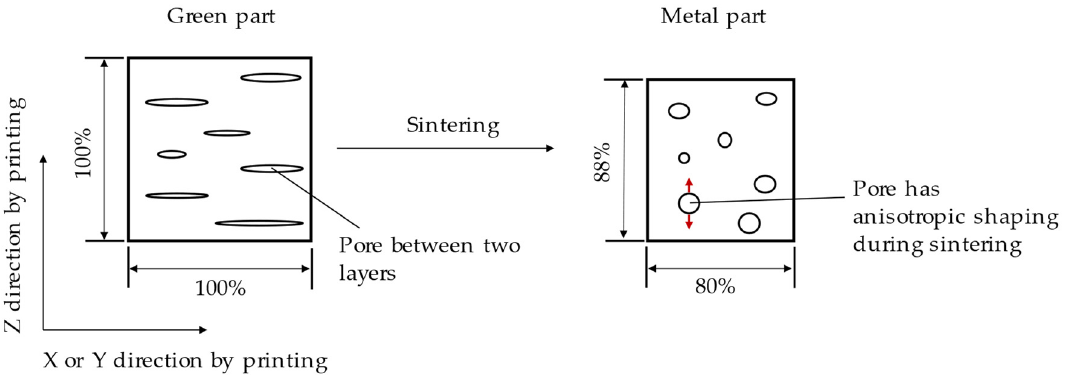
Figure 6. Anisotropic behavior for shrinkage caused by the change of pore structure during the sintering process.